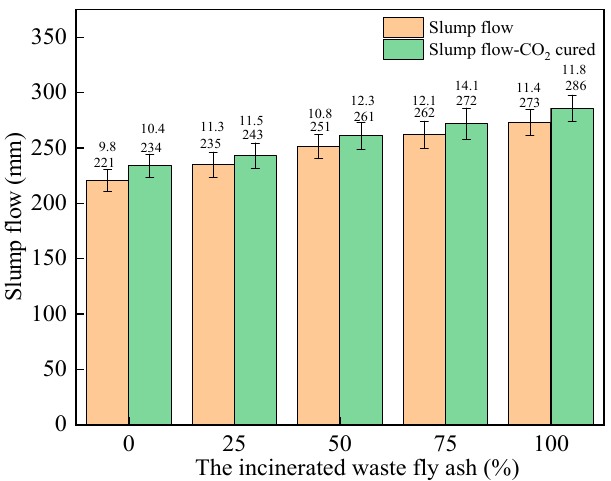
Figure 3. The slump flow of the fresh RPC.